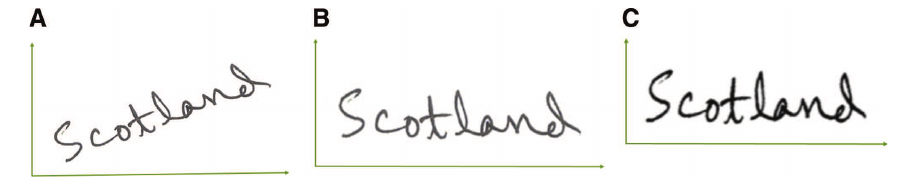
Figure 8: Sample Outputs of the Proposed Approach. (A) Input word, (B) slope-corrected word, and (C) slant-corrected